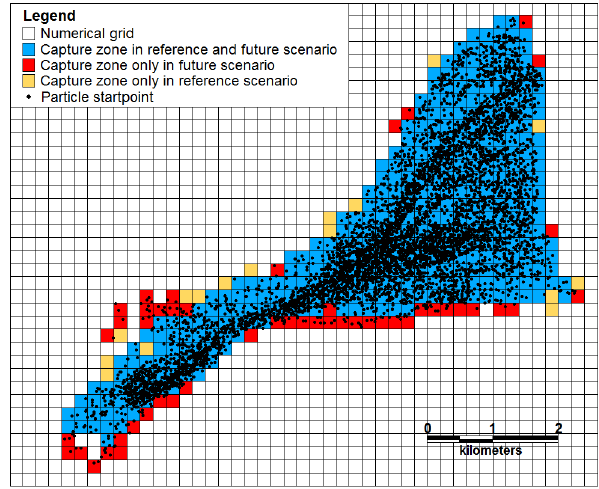
Figure 2. Methodology for estimation of and change in capture zone area for a well